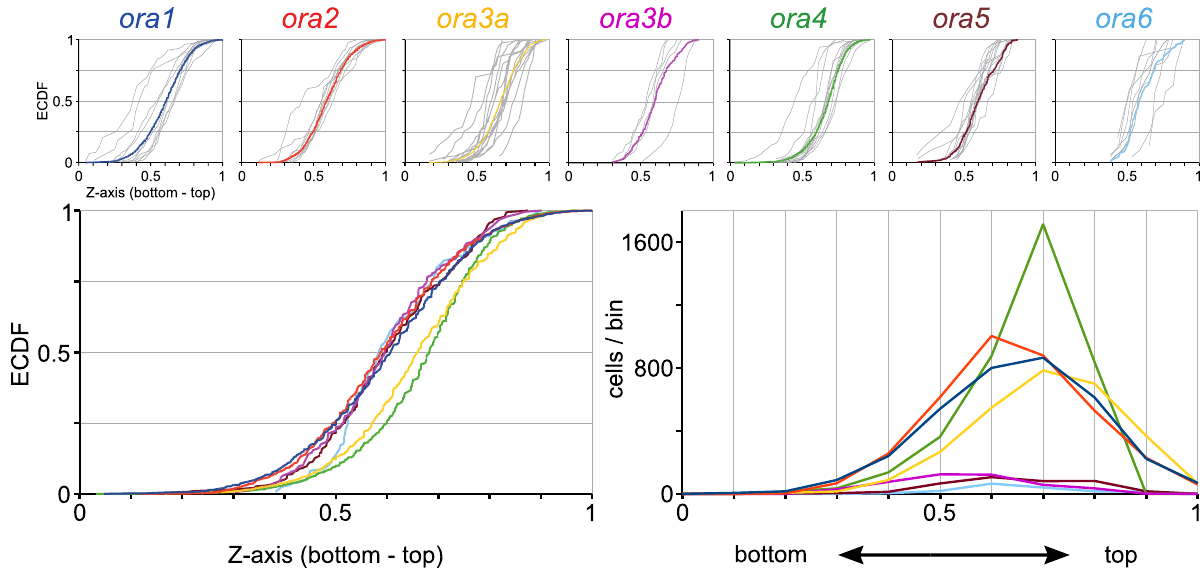
Figure 5. ora4 -expressing cells show preferential expression in the top of the olfactory organ. Quantitative assessment of distribution of ora-expressing neurons along the vertical z-axis (height-within-the-organ). Height within the olfactory organ was quantified as section number in a series of horizontal sections, and normalized to the total number of sections containing sensory epithelium, using the same set of cells, for which laminar height was determined. Relative height-within-the-organ ranges from 0 (bottommost section) to 1 (top section, near to the opening of the bowl-shaped olfactory organ). Upper row: The resulting distributions are shown unbinned (ECDF). Light grey curves represent the distribution for individual olfactory organs, colored curves represent the cumulative distribution for the respective genes. The color code for the ora genes is the same as in other figures to facilitate comparisons between different positional parameters. Lower row: Overlay of the distributions shown individually in the upper row, both as ECDF (left panel) and histogram (right panel). Due to lower resolution (all cells within one 10 µm section are assigned to a single z value) the ECDF curves appear Either kappe or potentially other, so far unknown minor OSN types could be candidates for expression of ORA3b, ORA5, and ORA6. But note that the distributions measured for ciliated and microvillous neuronal markers 13,21 average over many different receptors, and distributions for individual receptors might deviate considerably from the values averaged over the entire receptor family. The third minor cell population, pear neurons, is also located very apically, but has been shown to express the adorb (synonym A2c 18 ) gene—an olfactory receptor for adenosine—and is therefore not expected to harbor additional olfactory receptor genes 17,18 . Zebrafish, like other fish, possess a single olfactory epithelium, in which all the different olfactory receptor families are expressed. This is in contrast to the mammalian olfactory system, which segregates vomeronasal